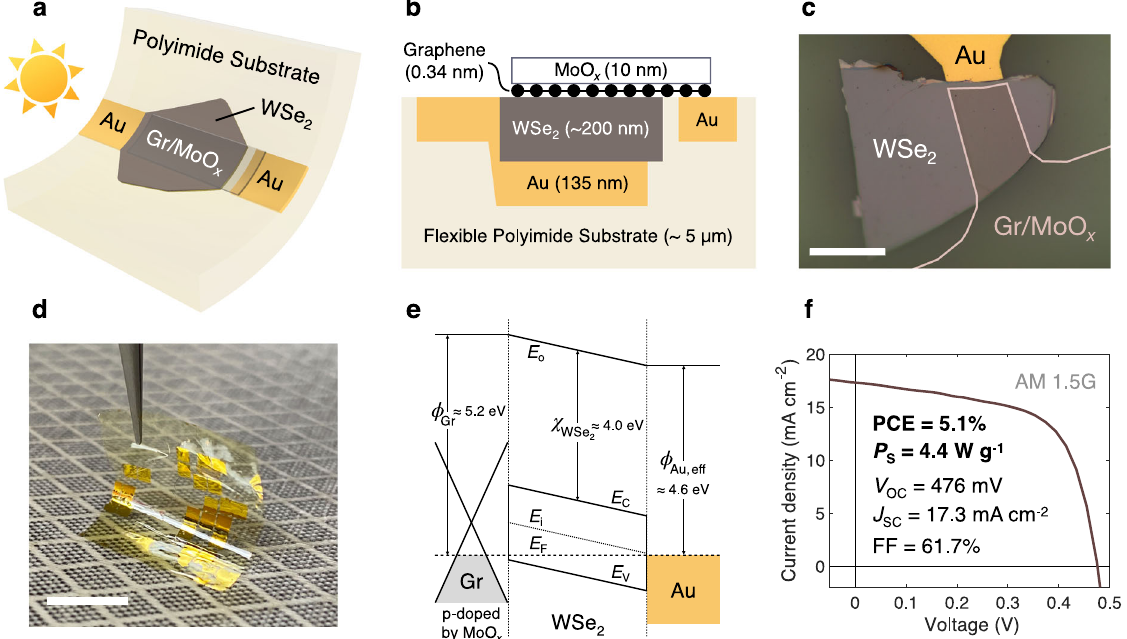
Fig. 1 Flexible WSe 2 solar cells. a Device schematic and b cross-section. c Top-down optical image of the device. Scale bar, 50 μ m. d Photograph of WSe 2 solar cells on a fl exible polyimide substrate. Scale bar, 1 cm. e Qualitative energy band diagram of the device. The Fermi level ( E F ) is pinned near the midgap at the Au – WSe 2 interface, but not at the van der Waals graphene (Gr) – WSe 2 interface 26,32,33,50,51 . MoO x increases the Gr work function and the built-in potential of the Gr – WSe 2 Schottky junction 53 . E 0 , vacuum level; E C , conduction band edge; E V , valence band edge; E i , intrinsic Fermi level; Φ Au, eff , Au effective work function; Φ Gr , Gr work function; χ , electron af fi nity of WSe 2 . f Measured current density J vs. voltage V under AM 1.5 G illumination. WSe 2 PCE, power conversion ef fi ciency. P S speci fi c power or power per weight. V OC open-circuit voltage. J SC short-circuit current. FF fi ll